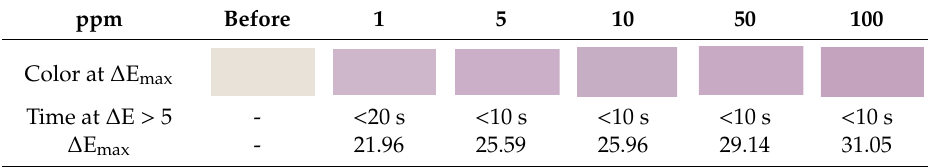
Figure 4. Time-dependent color differences of dyed sensor for gaseous HCl at concentrations from 1 to 100 ppm. Table 2. Color data of dyed sensors after exposure to various concentrations of gaseous HCl.